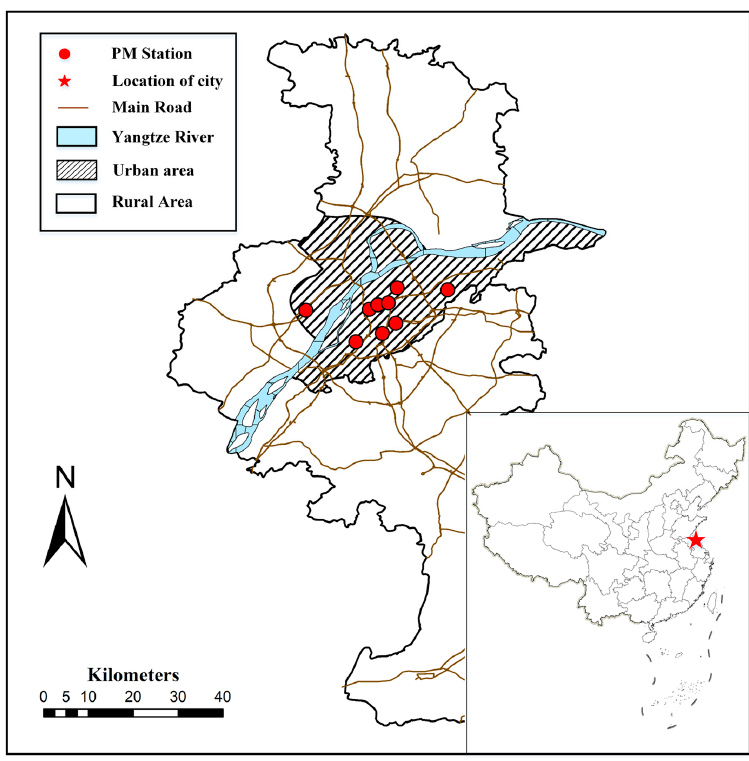
Figure 1. Map depicting the location of Nanjing in China (red star), air quality stations (red circles) and the distribution of main roads, urban areas, and rural areas. The corresponding PM 2.5 monitoring sites are: Pukou, Caochangmen, Shanxilu, Xuanwuhu, Maigaoqiao, Xianlindaxuecheng, Aotizhongxin, Zhonghuamen, and Ruijinlu (from left to right: six above and three below).